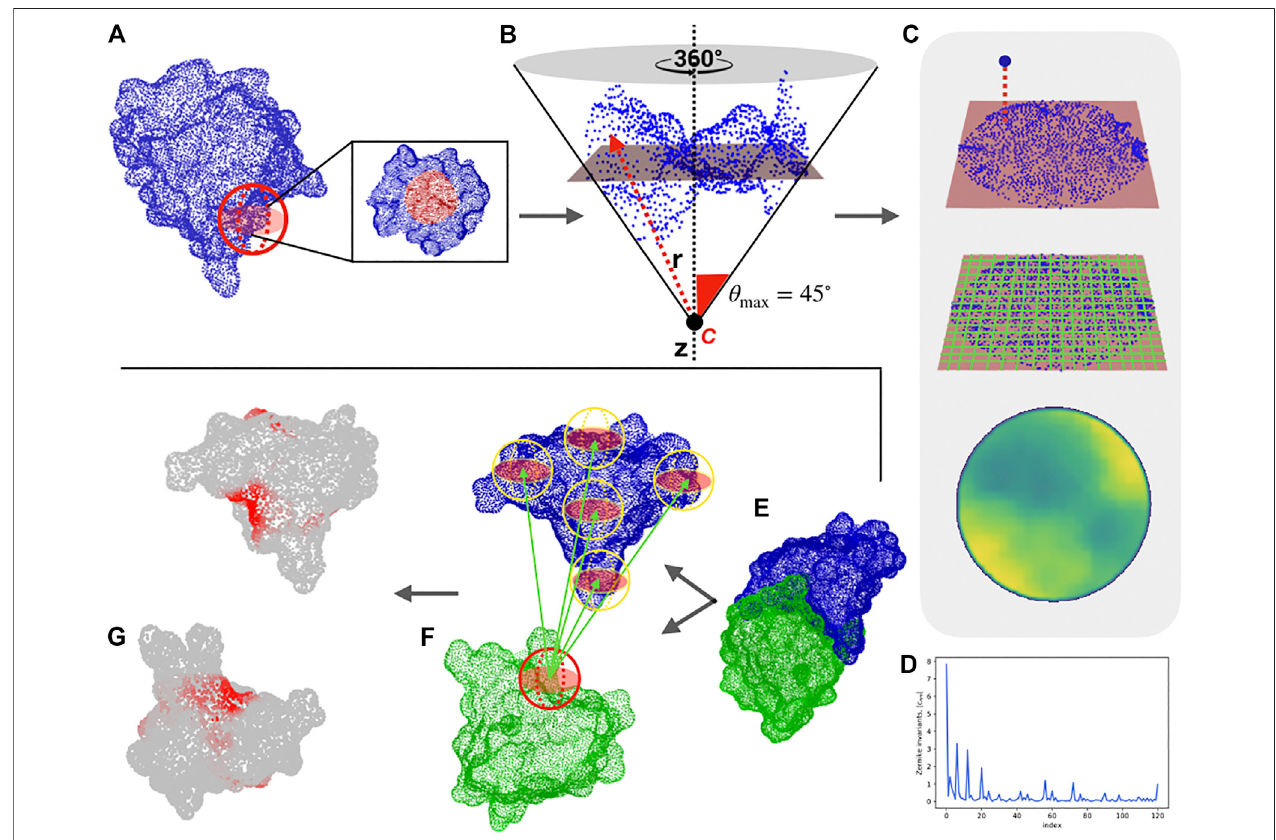
FIGURE1| Computational protocolforthecharacterizationofeach surfaceregionandtheblindidenti fi cationofthebindingsites. (A) Molecular solvent-accessible surfaceofaprotein (inblue)and example ofpatchselection(redsphere). (B) Theselectedpatchpointsare fi ttedwithaplaneand reoriented insuch awaythatthe z -axis (dotted line) passes through the centroid of the points and is orthogonal to the plane. A point C along the z -axis is de fi ned, such as that the largest angle between the perpendicularaxisandthesecantconnectingCtoasurfacepointisequalto45 ° .Finally,toeachpoint,itsdistance, r withpointCisevaluated. (C) Eachpointofthe surface is projected on the fi t plane, which is binned with a square grid. To each pixel, the average of the r values of the points inside the pixel is associated. (D) The resulting 2D projection of the patch can be represented by a set of 2D Zernike invariant descriptors. (E – F) Given a protein-protein complex (PDB code: 3B0F, in this example), for each surface vertex we select a patch centered on it and compute its Zernike descriptors. To blindly identify the binding sites, each sampled patch is compared with all the patches of the molecular partner, after which the minimum distance between its patch and all the patches of the molecular partner is associated with each vertex. (G) The surface point values are smoothed to highlight the signal in the regions characterized mostly by low distance values, (i.e. high shape complementarity).